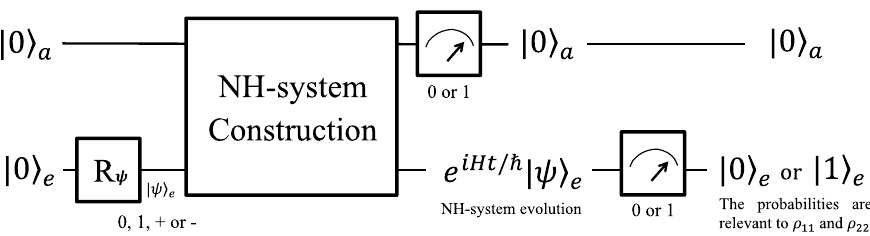
Figure 6. Schematic of quantum simulation to measure the entropy dynamics. The whole system is composed of an ancillary subsystem and a work qubit. For convenience, we use | 0 � a to denote the initial state of the subsystems that may consist one or two qubits depending on different cases. The work qubit is initialized in | 0 � a and can be rotated into one of the | 0 � e , | 1 � e or |±� e as needed to distinguish the NH systems in different phases. In the middle part, one of the NH systems will be constructed in an indeterministic way basted on the first quantum measurement. The basis of the two measurements are chosen as the logic | 0 � and | 1 � . If the first output is | 0 � a , the result will be recorded, in which case the evolution of the work qubit is governed by one of the NH Hamiltonians. The second measurement is performed on the work qubit, and either | 0 � e or | 0 � e will be output. By repeating the process or inputting an ensemble of qubits, the ratio of the frequencies of outputs | 0 � a | 0 � e and | 0 � a | 1 � e are the experimental values of m = ρ 11 /ρ 22 , calculating the entropy by Eqs. (5) and